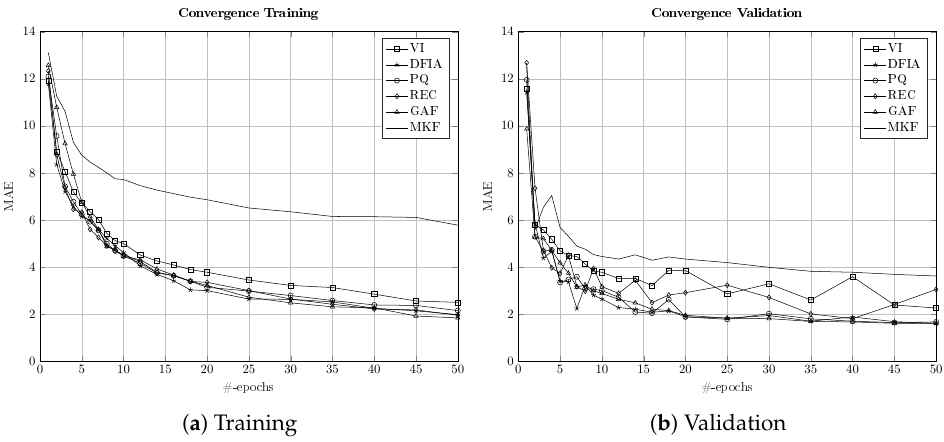
Figure 4. Convergence of the six time series 2D representation methods for 50 epochs of training using the REDD database during ( a ) training and ( b ) validation. Table 7. Average Execution Time (AET) per sample for different time series imaging approaches. Imaging